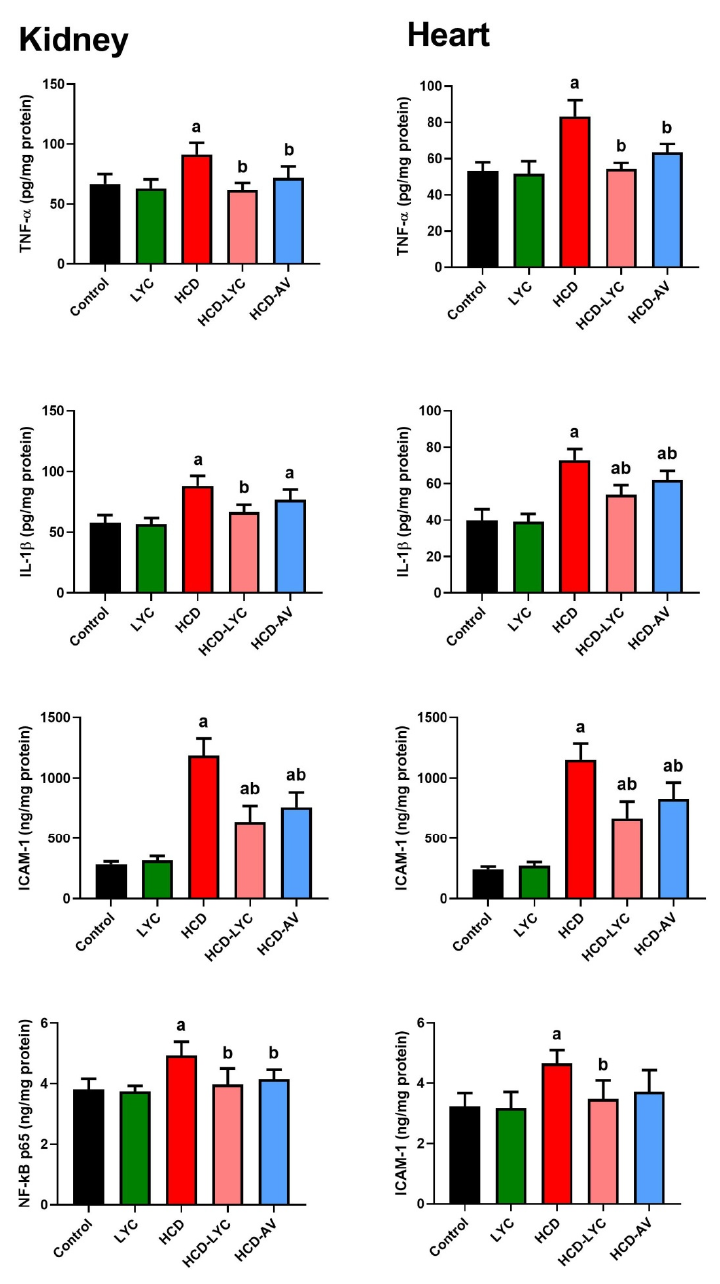
Figure 5. Effects of dietary cholesterol and lycopene on cardiac and renal tumor necrosis factor- alpha (TNF- α ), interleukin-1 beta (IL-1 β ), nuclear factor kappa B (NF- κ B), and intercellular adhesion molecule 1 (ICAM-1) levels in rats over 12 weeks. Letters a and b indicate statistically significant differences between control and HCD groups, respectively, at p <